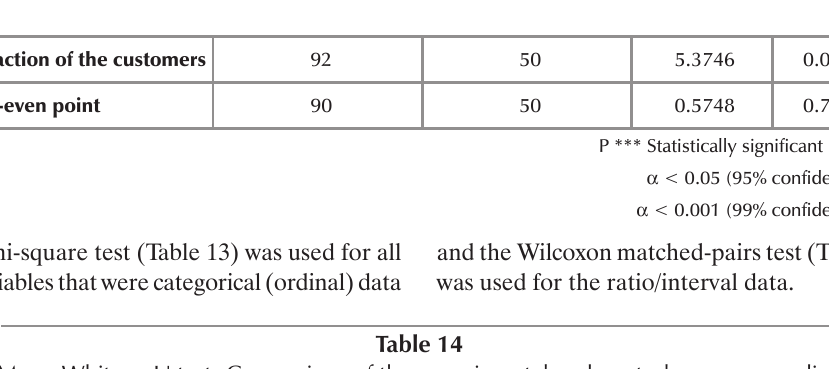
Mann Whitney U test: Comparison of the experimental and control groups regarding their business performance